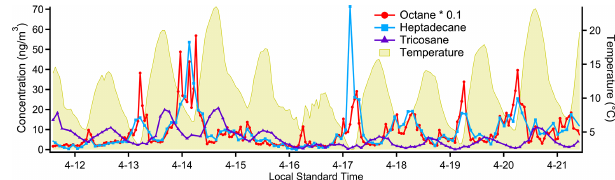
Figure 10. Timelines for characteristic species from each of the three main groupings of compounds evident in the correlation ma- trix (Fig. 9). The two more volatile groups, represented by octane and heptadecane, tend to peak in the early morning, consistent with morning-rush-hour cold-start emissions. The least-volatile group, which includes tricosane, appears to have an evaporative source as it tracks closely, but slightly delayed, with ambient